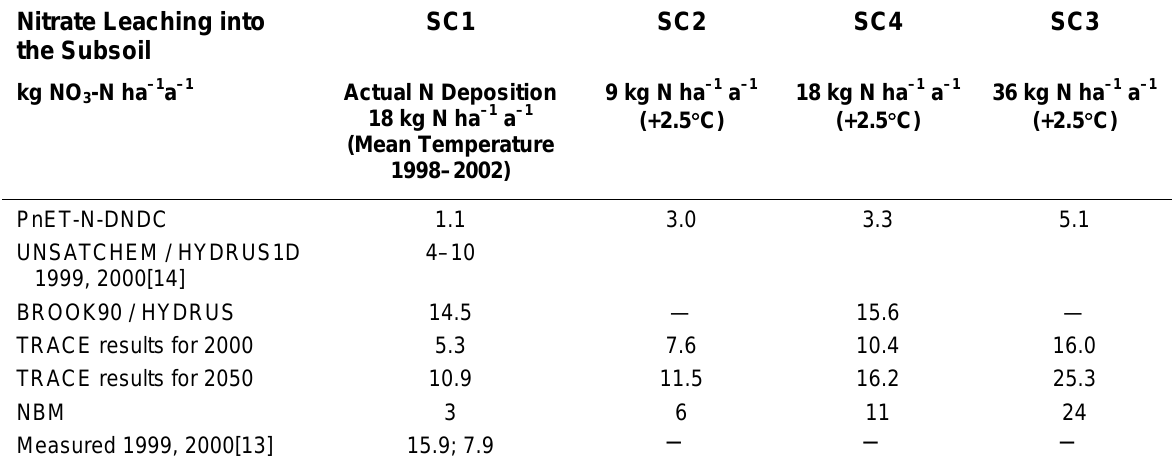
Nitrate Leaching in Accordance with the Results from NBM, BROOK90/HYDRUS, and